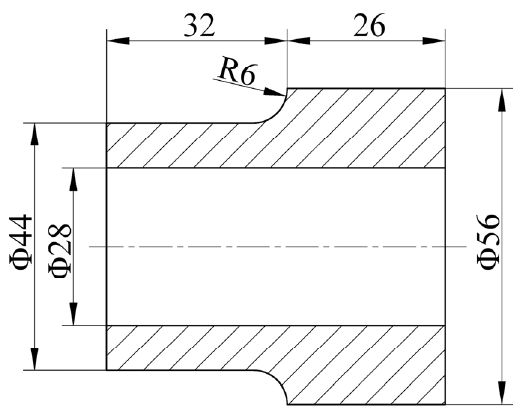
Figure 15. Preform of shrinkage ratio experiment (unit: mm).